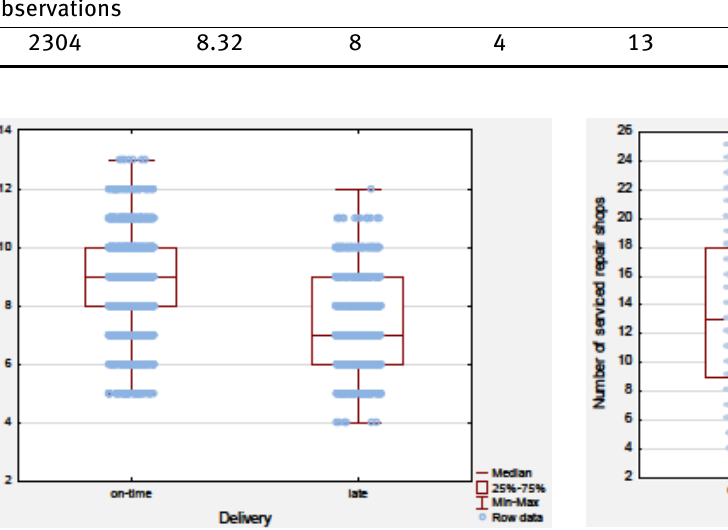
Figure 2: Comparison of delivery times depending on the number of orders.